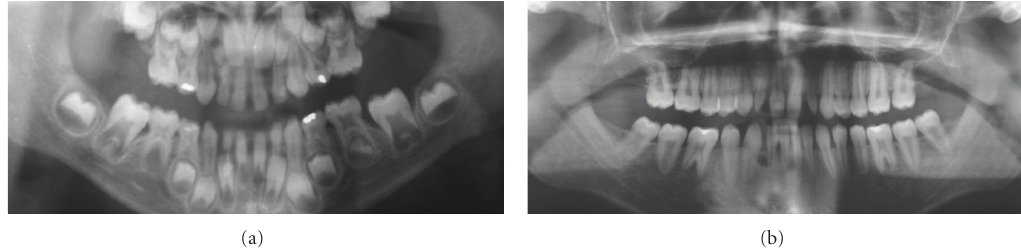
Figure 8: (a) OPT (6 years and 4 months) showing agenesis of upper molars in patient 4. (b) OPT (18 years) showing taurodontism of upper and lower molars and paraplasia on the distal aspect of the right upper third molar in patient 4.